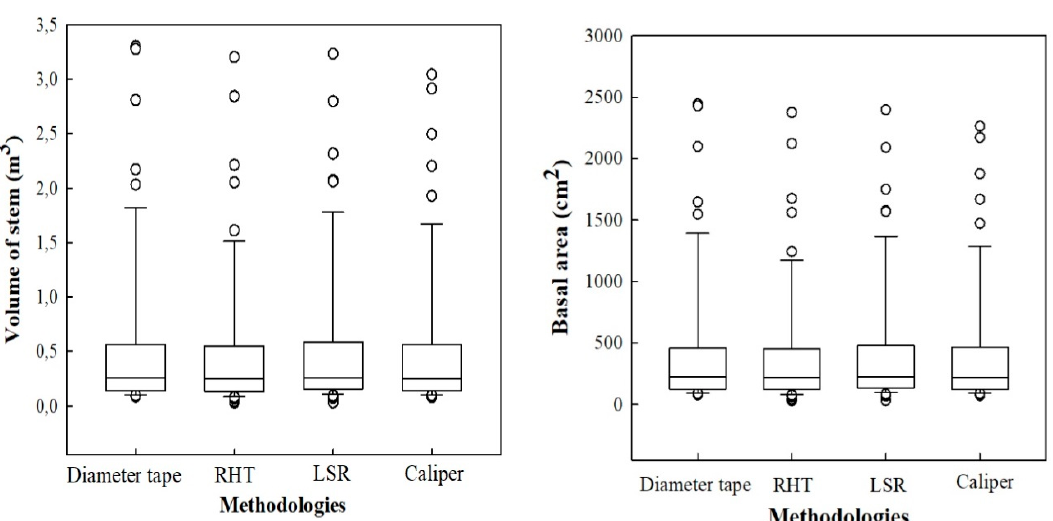
Figure A2. The number of individuals identified within the diameter inclusion limit (DBH ≥ 10 cm) for respective methodology applied, i.e., diameter tape (D ‐ tape), electronic caliper (Caliper), terrestrial laser scanner circle fitted via Hough transformation (RHT), and least ‐ squares method (LSR).